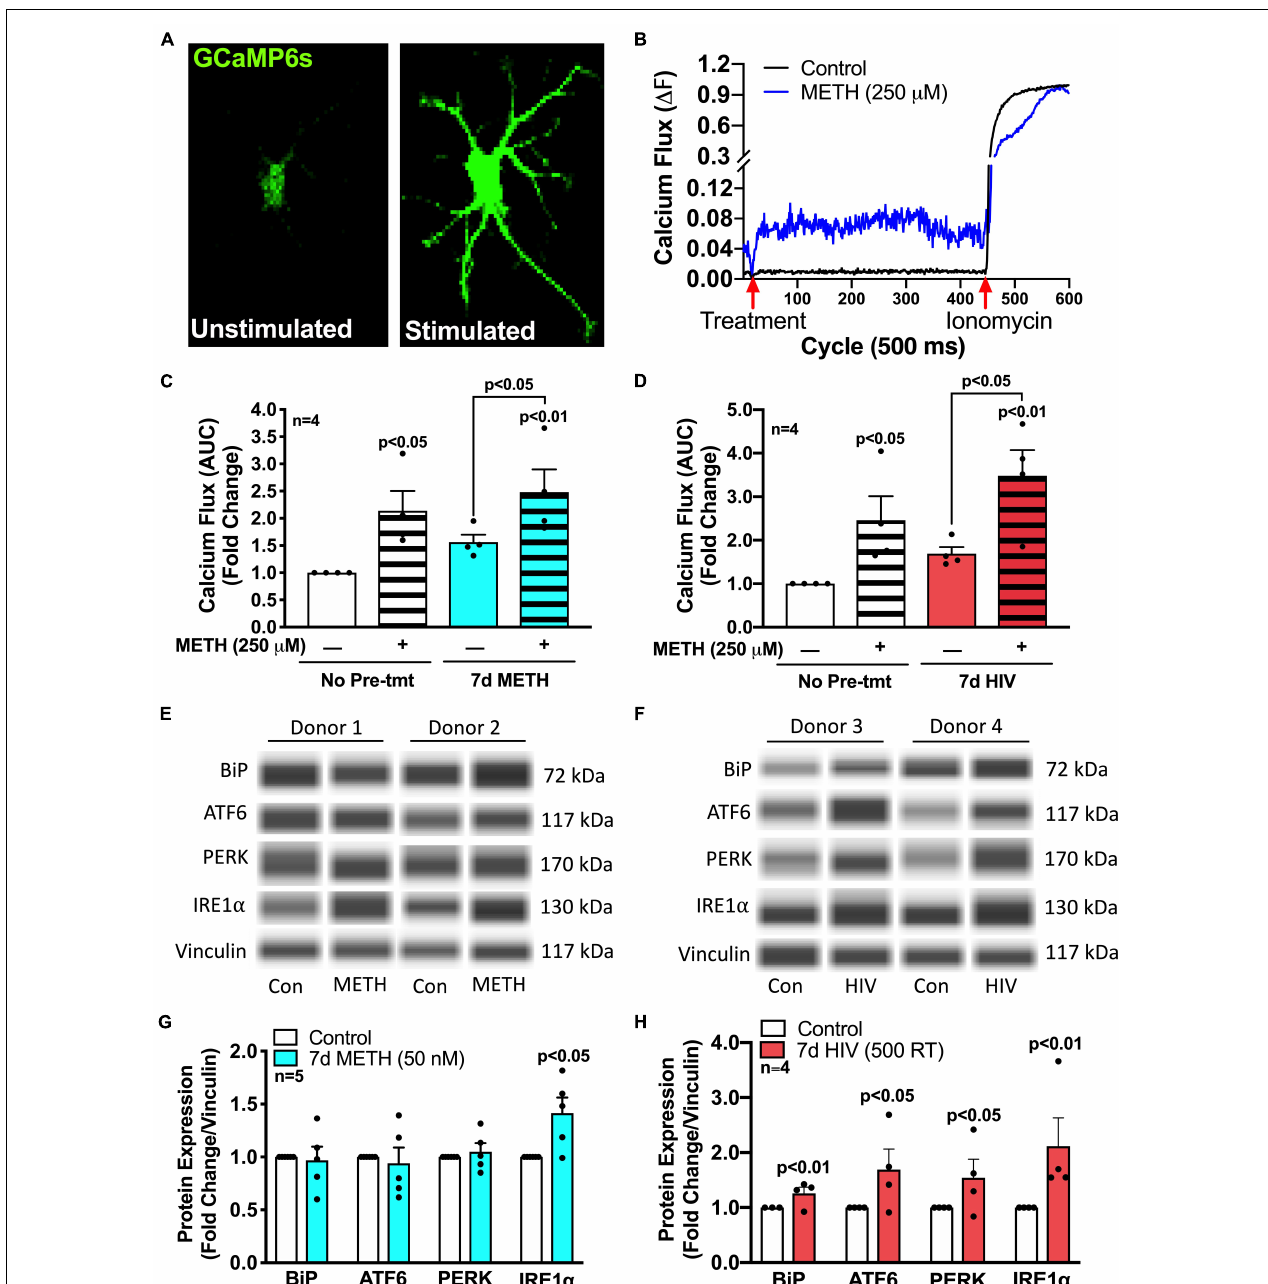
FIGURE 3 | METH and HIV-1 upregulate ER/UPR signaling mediators. Astrocytes were treated with (C,E) METH (50 nM) for 7 days (blue bars) or (D,F) pseudotyped HIV-1 (500 RT) for 7 days (red bars) before (A–D) calcium imaging or (E,F) protein analysis via Simple Wes. (A–D) Astrocytes were transfected with a GFP-calmodulin calcium sensor (GCaMP6s) for 48 h prior to calcium flux analysis. (A,B) Time series confocal imaging was used to measure changes in fluorescence every 500 ms for a total of 5 min (600 cycles). (B) Representative calcium flux line tracings illustrate the change in astrocyte calcium flux ( (cid:49) F) at any given time point, with control media or METH (250 µ M) at 20 cycles (10 s) and ionomycin (10 µ M) at 450 cycles (225 s). Calcium flux was calculated by: (cid:49) F = (F-F 0 )/(F max -F 0 ), where F is the fluorescence intensity at any given time; F 0 is the baseline (1 – 20 cycles) fluorescence intensity, and F max is the maximum fluorescence intensity when exposed to ionomycin (450 – 600 cycles). (C,D) Area under the curve (AUC) was calculated by the sum of (cid:49) F following treatment with control media or METH (250 µ M) at 20 cycles (10 sec) and before ionomycin (10 µ M) at 450 cycles (225 s). Individual dots represent the average AUC from a minimum of 20 cells per biological donor and are graphed as fold changes. One-way ANOVA was performed for statistical analysis followed by Fisher’s LSD test for stand-alone comparisons to account for sensitivity of calcium flux variation across different biological donors. (E–H) Protein expression of BiP, ATF6, PERK, and IRE1 α was measured via Simple Wes post-treatment of (E,G) chronic (7 days) METH (50 nM) or (F,H) HIV-1 infection (7 days; 500 RT). (E,F) Representative blot images are illustrated from two separate biological donors per post-treatment paradigm. (G,H) Data from a minimum of four donors are compiled for graphical representation. Individual dots on graphs represent fold changes to vinculin for separate biological donors. Statistics were performed using ratio-paired t -tests for individual targets per condition.